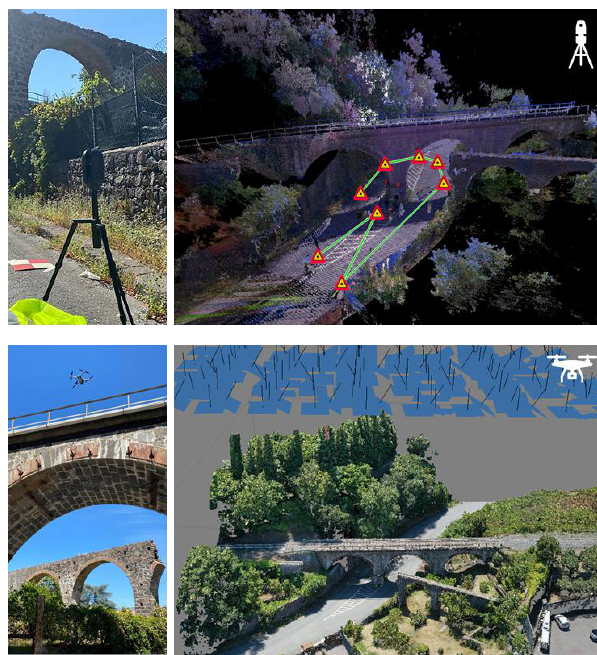
Figure 2 . The result of the survey campaign for a three-arch bridge in the municipality of Mascali (CT). A) Leica BLK360; B) DJI MAVIC 2